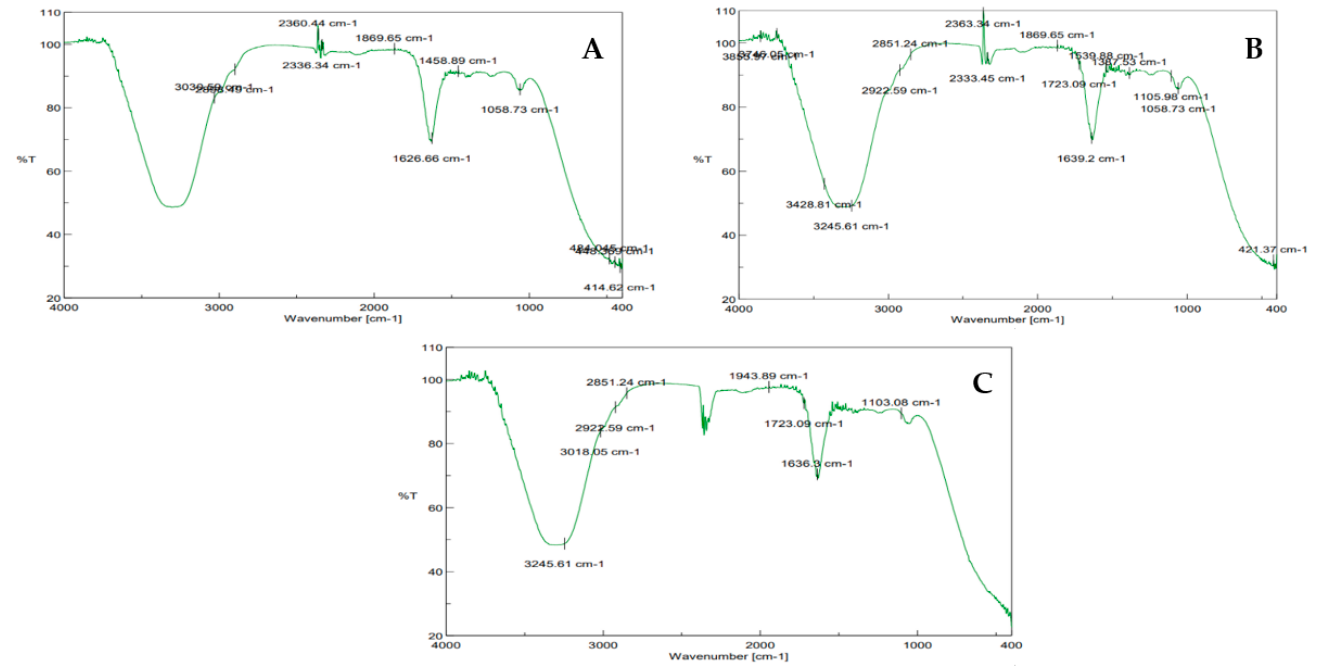
Figure 1. Transmission electron microscopy (TEM) image of PS, HA & PS + HA dispersed in Milli-Q water.